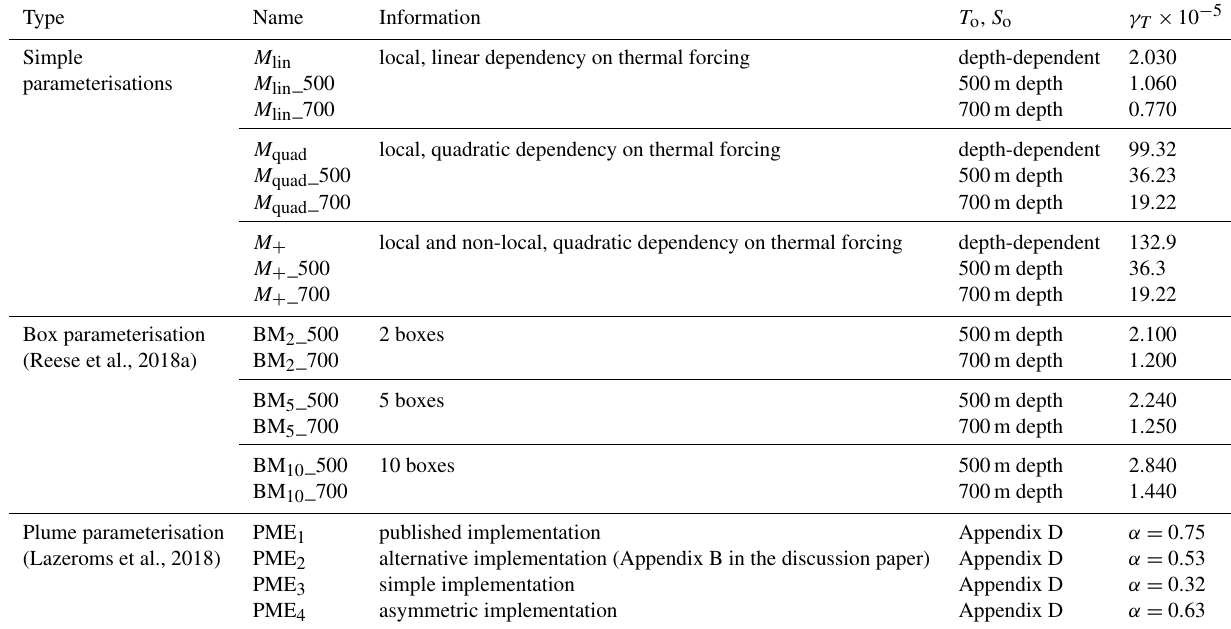
Table 3. Parameterisations used to compute melting in stand-alone ice-sheet simulations. The last column lists the calibrated γ T obtained from the WARM profile, except for the plume parameterisation where a multiplicative coefficient α is used